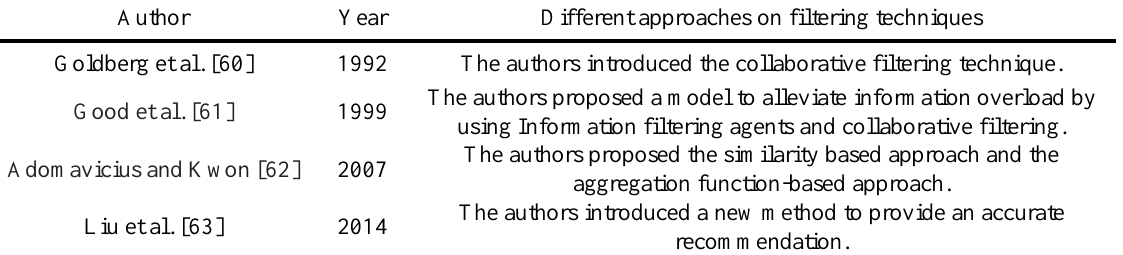
Table 4. Literature review on filtering